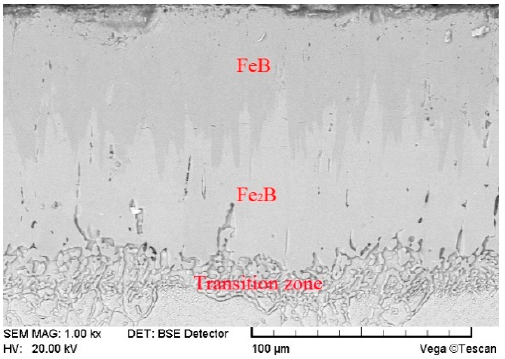
Figure 6. Cross-sectional morphology in backscattering (BSE)